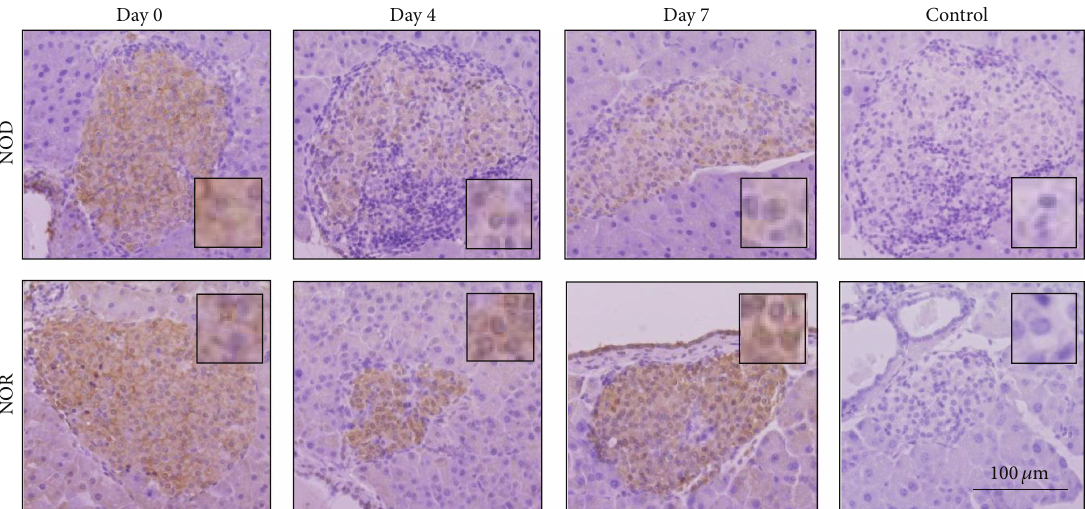
Figure 4: GLUT2 immunohistochemistry stainings in NOD and NOR islets. Representative islet images are shown demonstrating GLUT2 expression levels prior to (day 0) and after STZ application (days 4 and 7). Hematoxylin counterstaining was performed following anti-GLUT2 antibody application. Tissues depicted as “control” were treated with secondary antibody only.